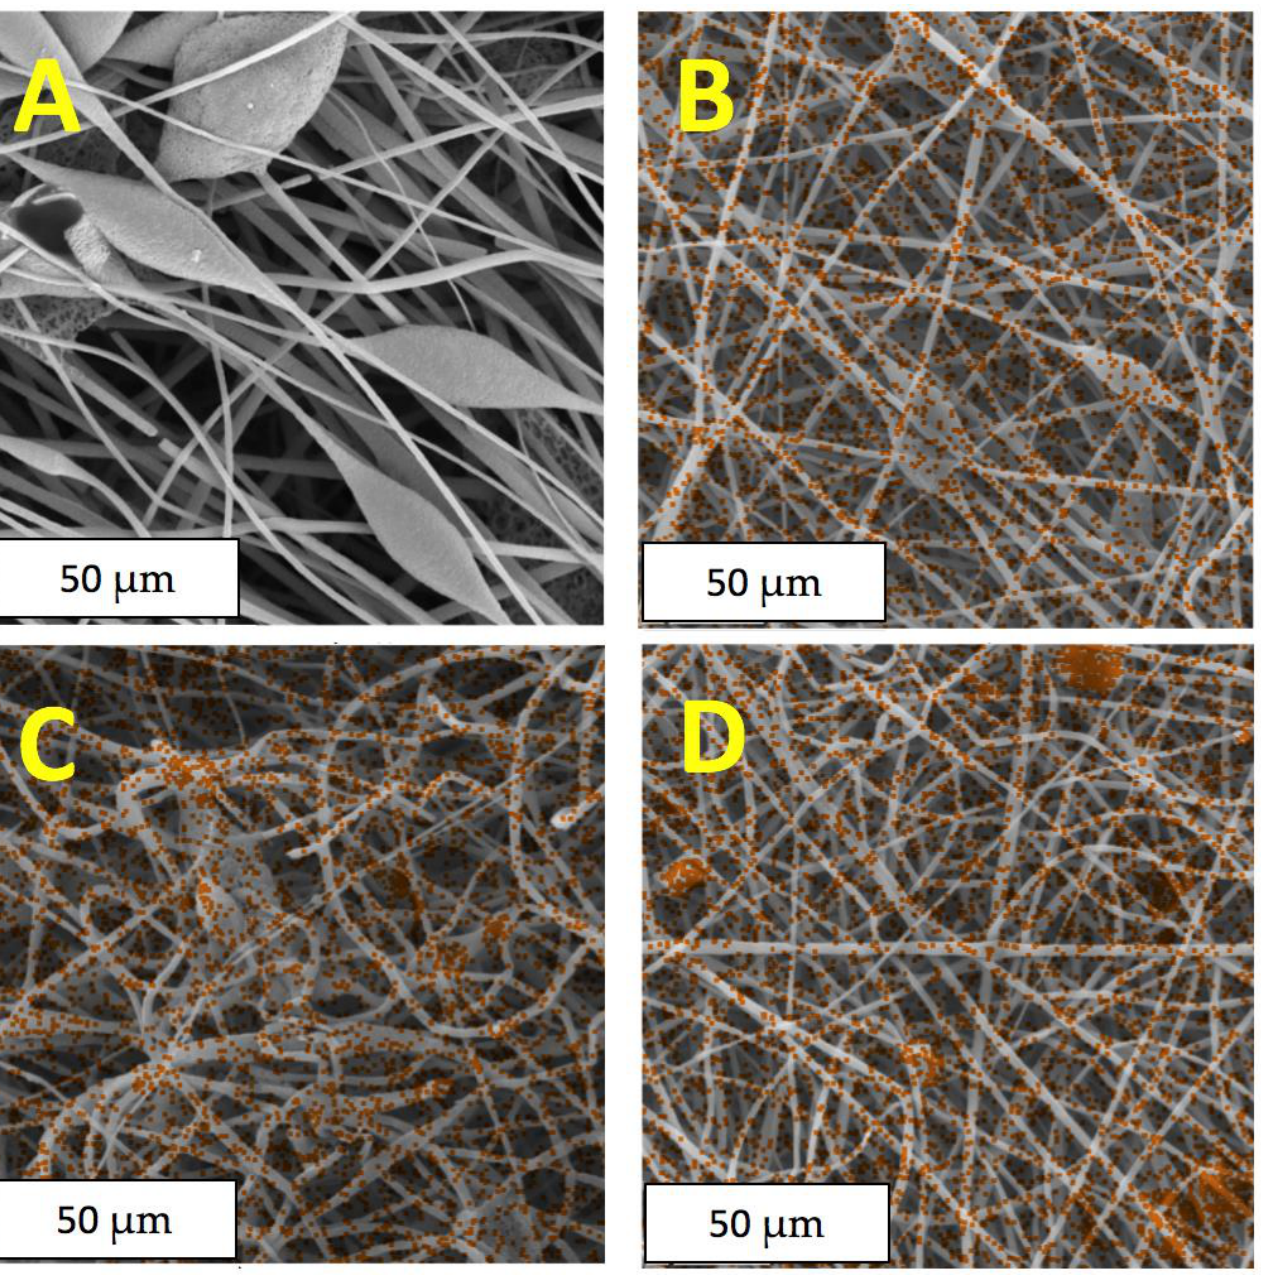
Figure 4. EDX elemental analysis of iron atoms in the Hmi /PHB samples with different content of hemin: ( A ) 0 wt.%, ( B ) 1 wt.%, ( C ) 3 wt.%, ( D ) 5 wt.%. hemin: ( A ) 0 wt.%, ( B ) 1 wt.%, ( C ) 3 wt.%, ( D ) 5